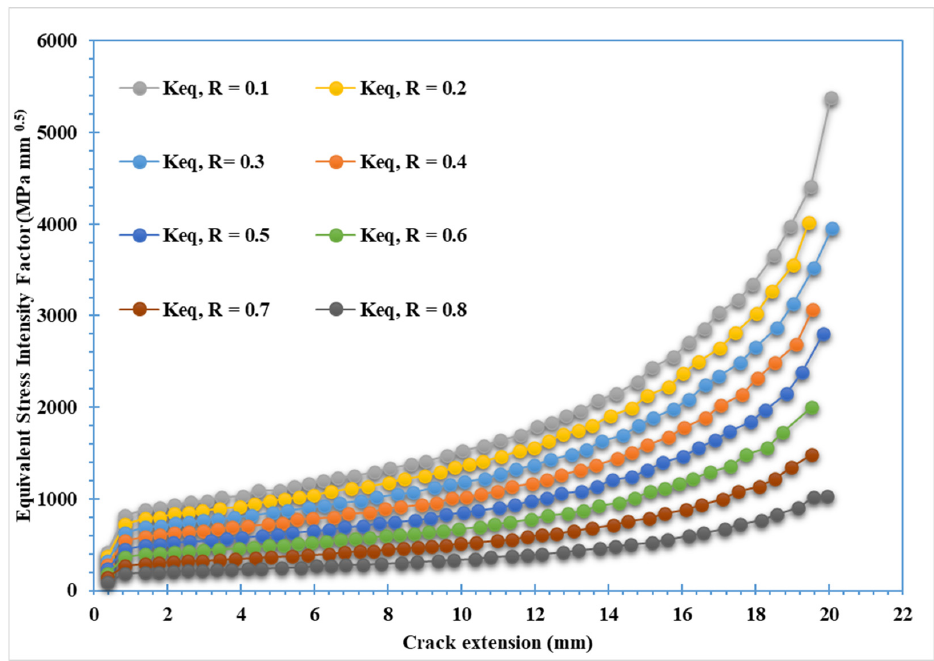
Figure 12. Equivalent stress intensity factor for specimen 3 with different stress ratios.